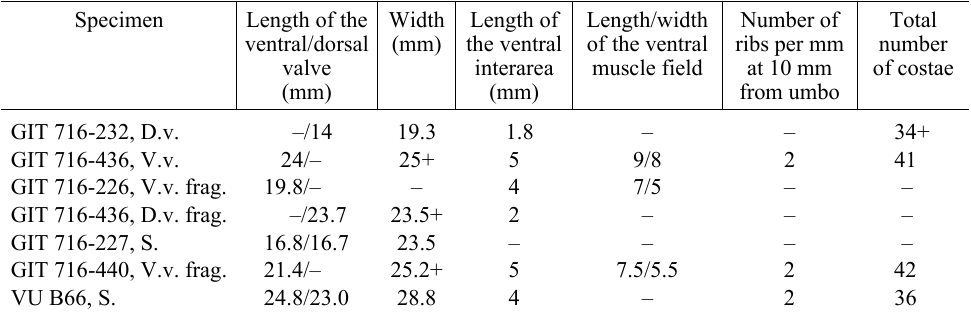
Table 2. Measurements of specimens. D.v., dorsal valve; V.v., ventral valve; S., shell; frag., fragment. The larger than measured size is marked by ‘+’